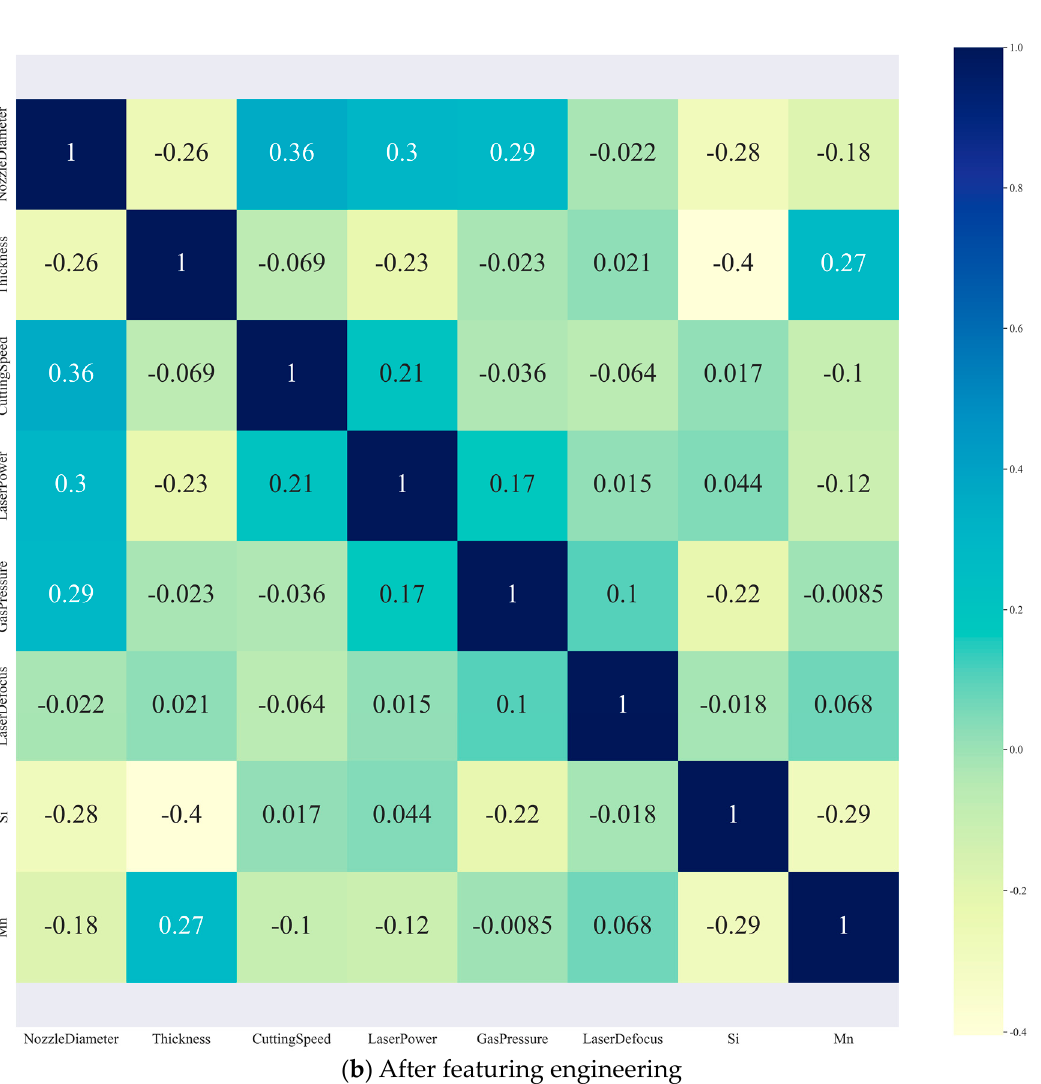
Figure 4 . Pearson correlation coe ffi cient between the features ( a ) before and ( b ) after feature Figure 4. Pearson correlation coefficient between the features ( a ) before and ( b ) after feature engi- neering. If the correlation coefficient between two features is greater than 0.9, it is determined that there is a strong correlation between them, and only one of the two features can